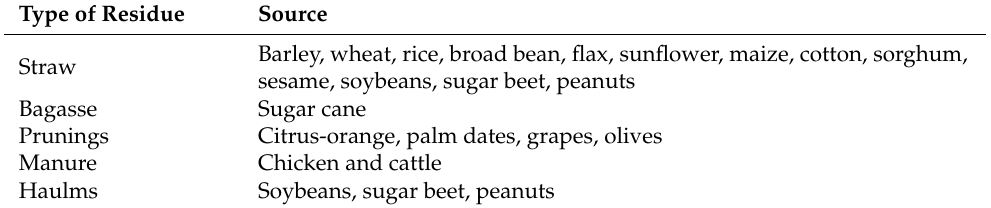
Table 6. Types of residues and their agriculture [47].